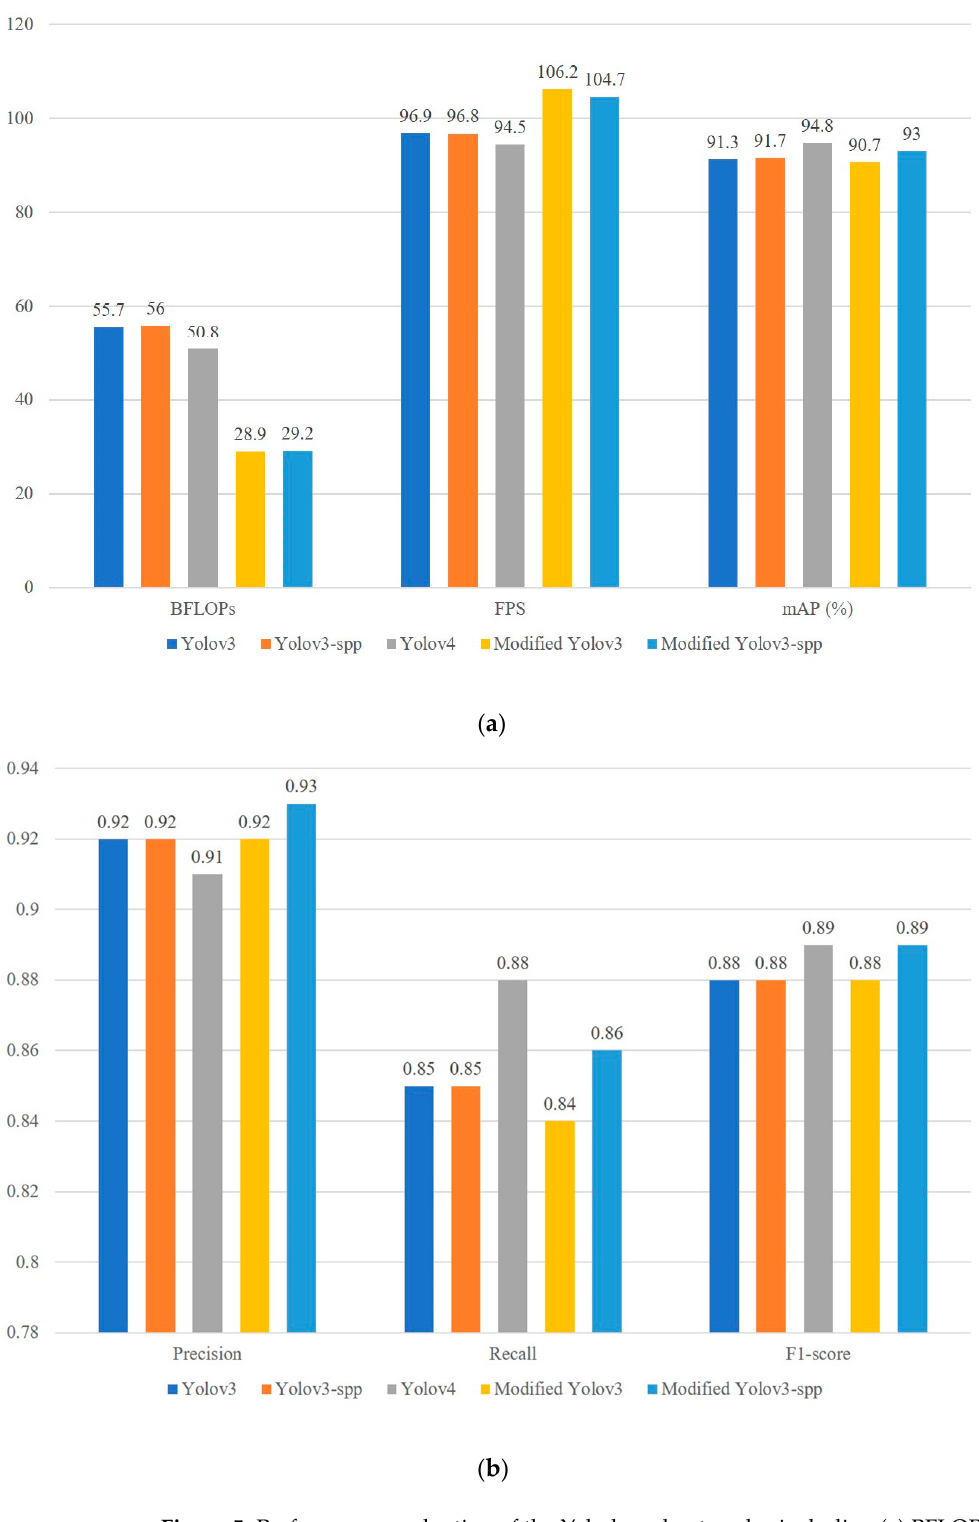
Figure 5. Performance evaluation of the Yolo-based networks, including ( a ) BFLOPs, FPS and mAP; ( b ) Precision, Recall, and F1-score. Table 5. Detection accuracy of the proposed modified methods and other networks on testing data.